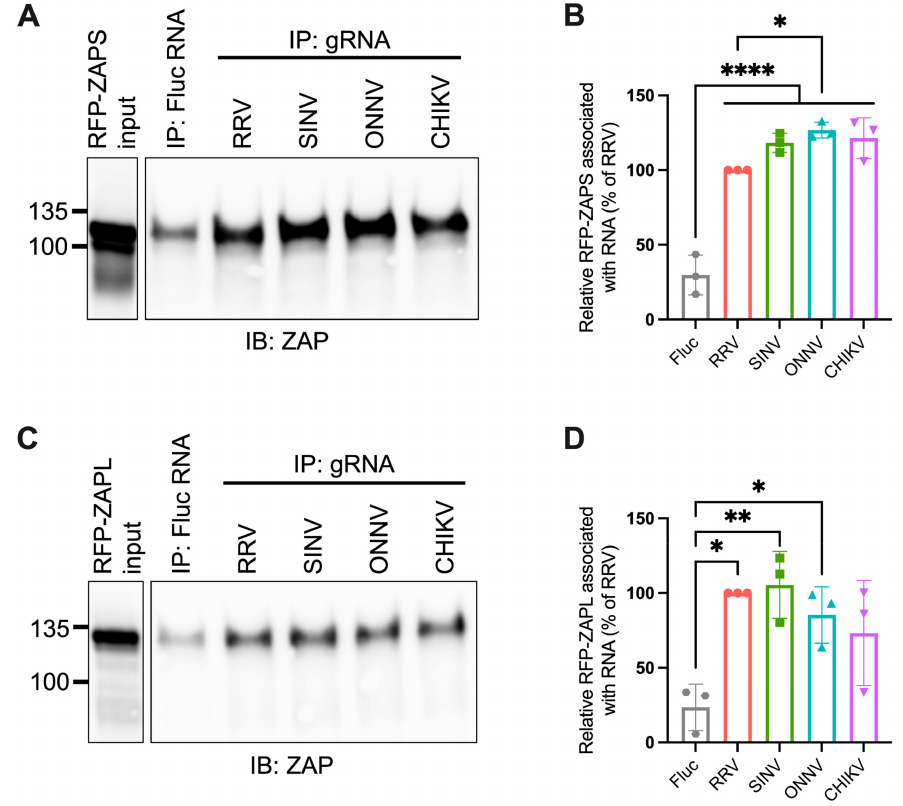
Figure 3. ZAPS and ZAPL binding to alphavirus genomic RNA do not correlate with alphavirus replication sensitivity to ZAP. ( A,C ) Lysates of ZAP KO 293T cells with induced expression of